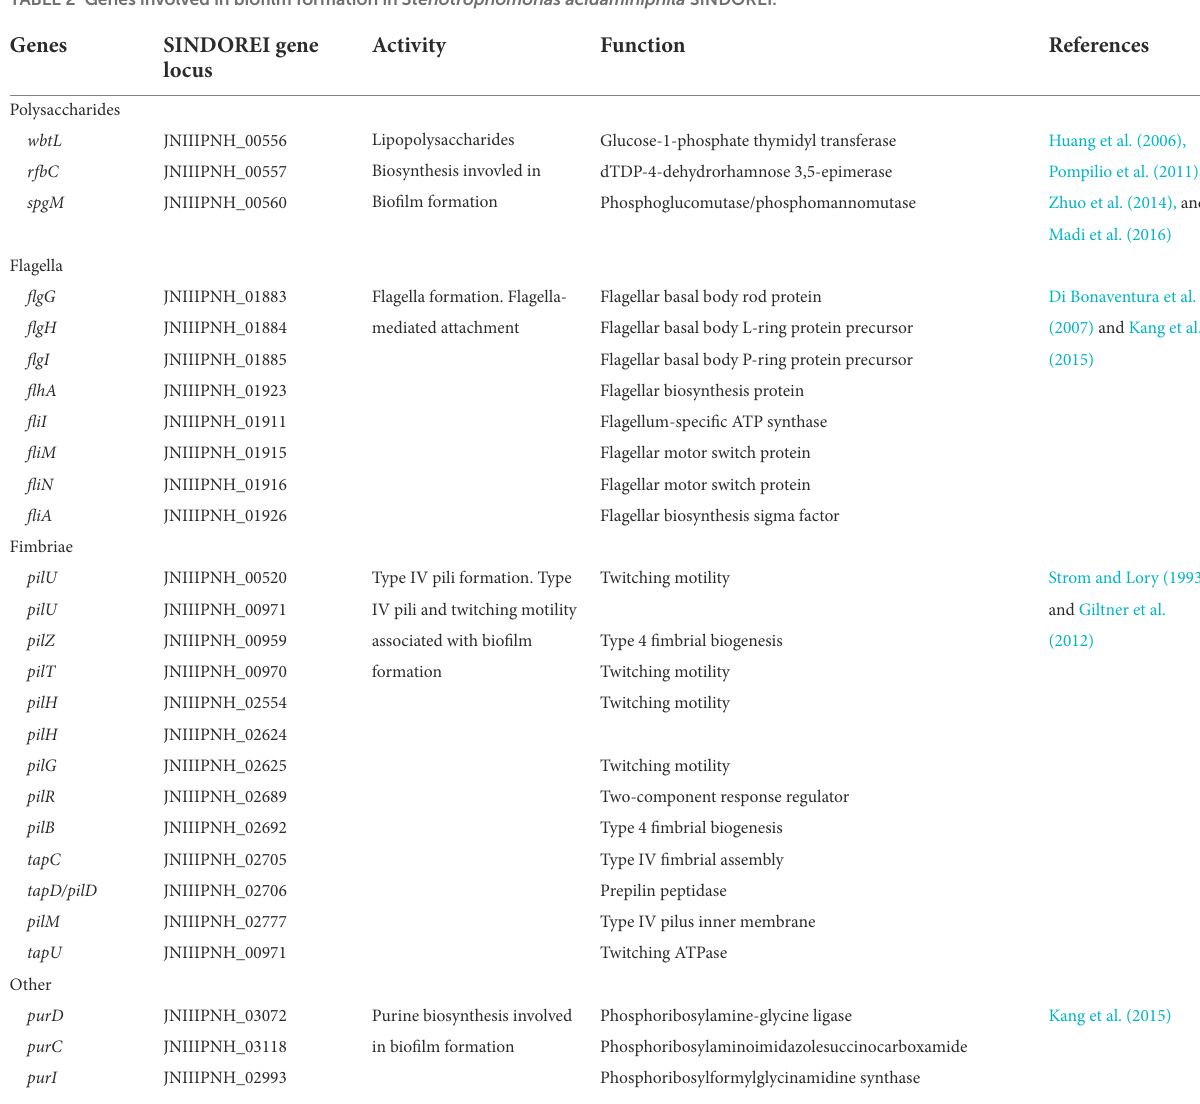
TABLE 2 Genes involved in biofilm formation in Stenotrophomonas acidaminiphila